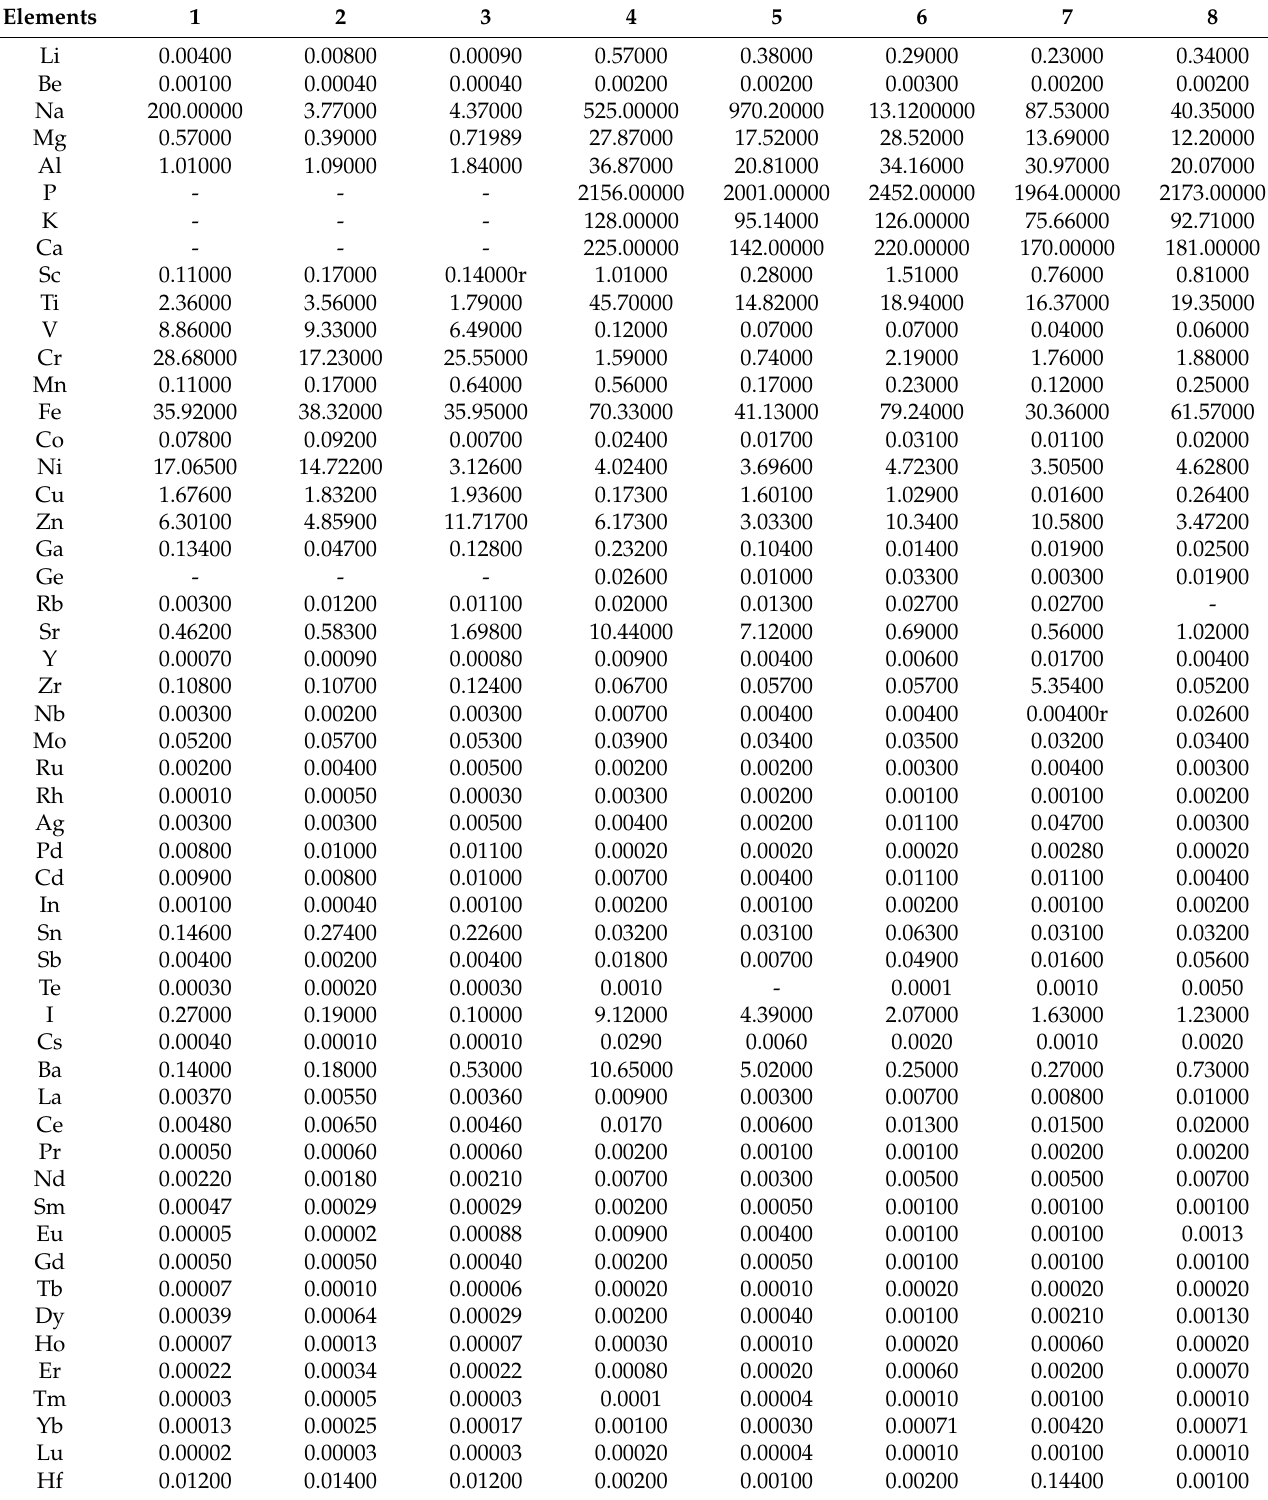
Table 2. Results of ICP-MS (in ppm) for crude oils of Sredneobsky and Oktyabrsky